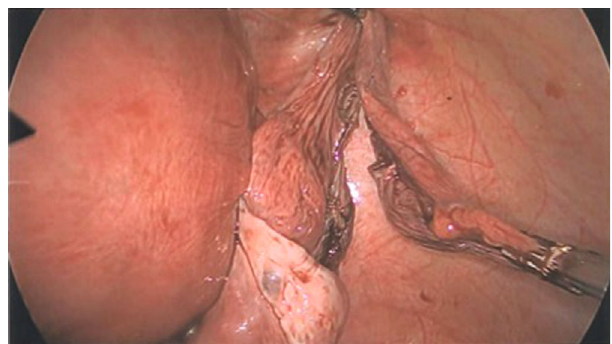
Figure 4: The right adnexa following complete excision of the cyst. Note the normal right ovary and gravid